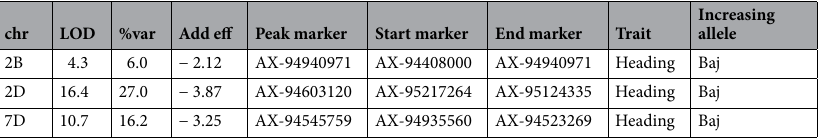
Table 1. Summary of the QTL result for heading date in the UK environment. chr chromosome, %var percentage variance explained by the QTL, start and end marker border the QTL confidence